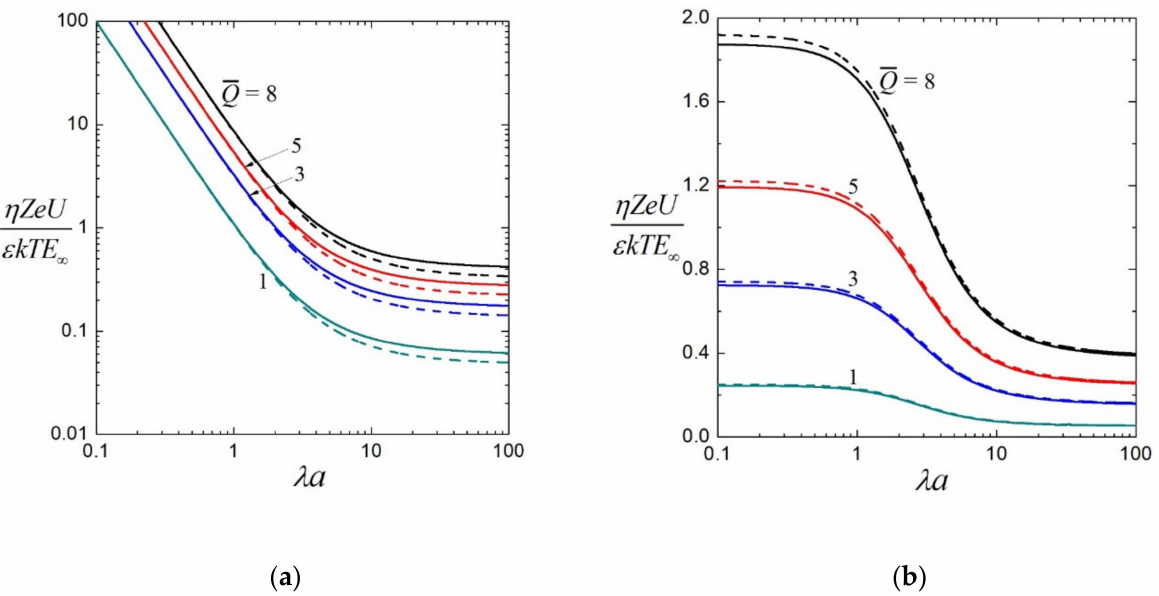
Figure 5. Scaled electrophoretic mobility η ZeU / ε kTE ∞ versus λ a for a suspension of soft spheres with ϕ = 0.125: ( a ) r 0 / a = 0 (porous spheres) with the solid and dashed curves representing calculations for the Happily and Kuwabara models, respectively; ( b ) r 0 / a = 1/2 for the Happel model with the solid and dashed curves denoting results obtained from conditions (13) and (14), respectively, at the cell border.